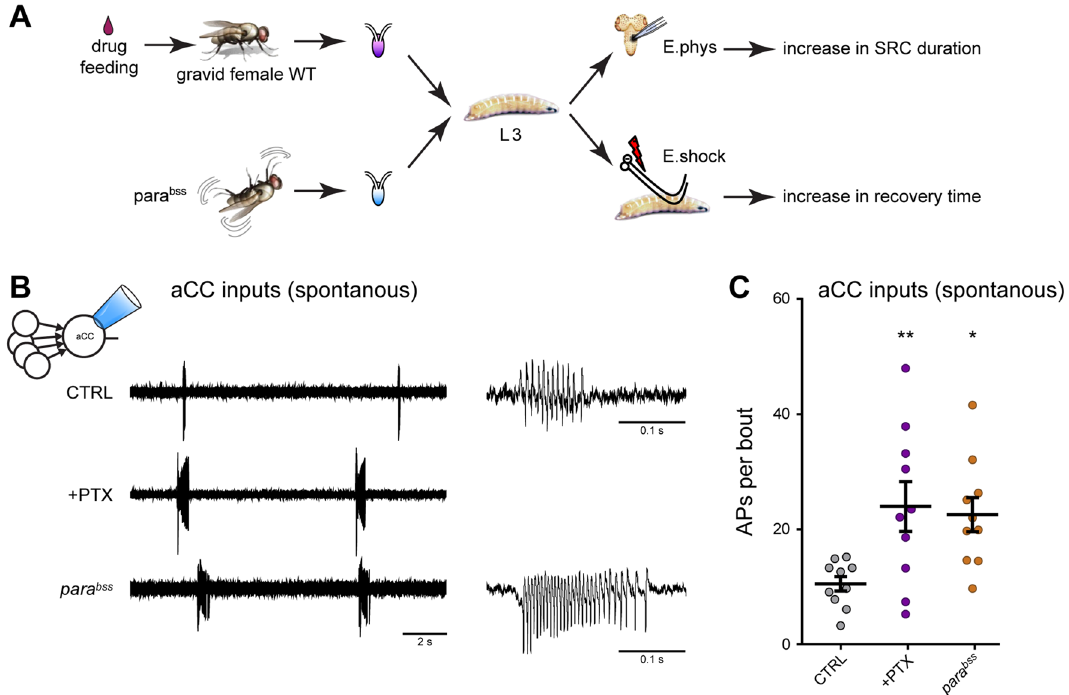
Figure 1. Activity manipulation during the embryonic critical period affects synaptic excitation of the aCC motoneuron. ( A ) Schematic representation of the experimental procedure. Early chemical manipulation was achieved by feeding PTX to wild-type gravid females. The seizure-prone para bss mutant was also used to investigate hyper-excitability 48 . Five days later, wall-climbing L3 were tested by either electrophysiological recording from aCC motoneurons or by electroshock, in order to measure change to synaptic drive or susceptibility to induced seizure, respectively (see Figure S1). ( B ) Loose patch recordings from L3 aCC motoneurons showing increased endogenous (i.e. spontaneous) spiking activity in conditions of excessive excitation (PTX and para bss , see also Figure S1). ( C ) Quantification of the number of action potentials per bout. One-way ANOVA (F (2, 27) = 3.91, p = 0.03) followed by Bonferroni’s post-hoc test ( n = 10 in each